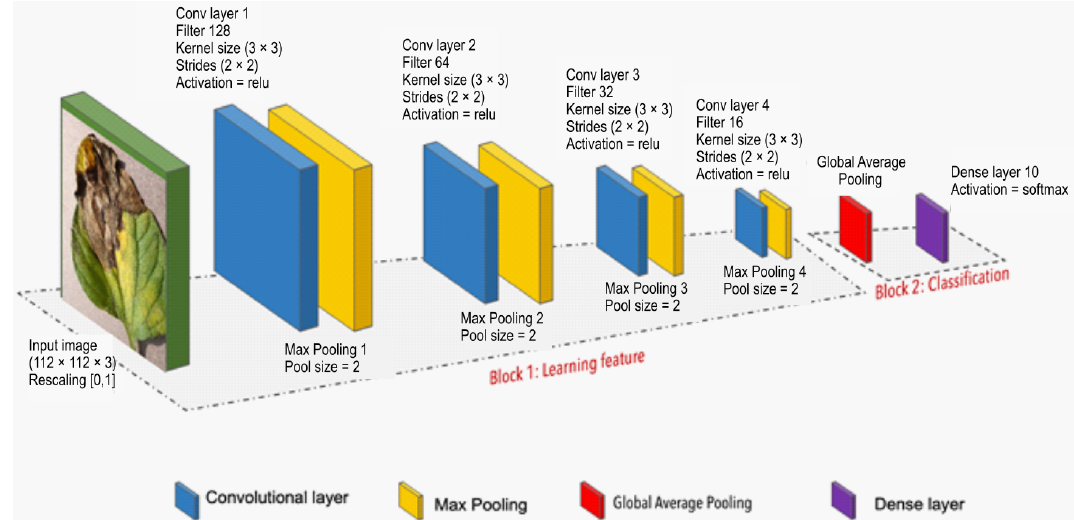
Figure 3. Representation of the proposed algorithm for tomato disease detection. Table 1. Information on the layers structure of the proposed